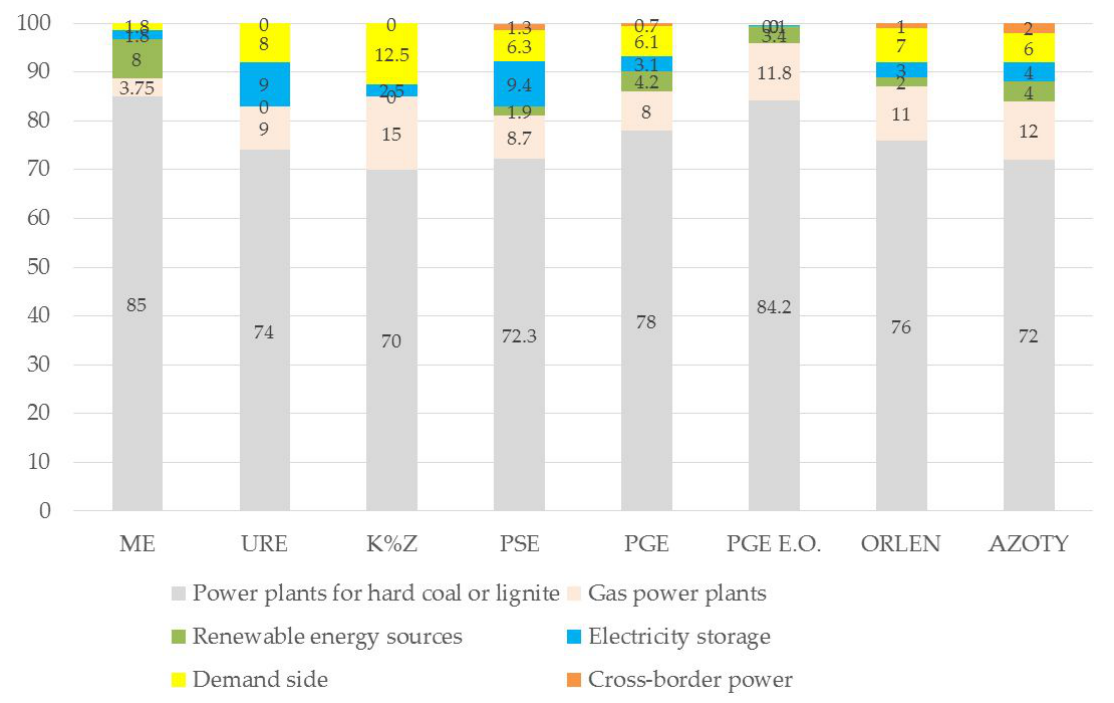
Figure 4. Percentage share of generation/reduction technology in the capacity market.